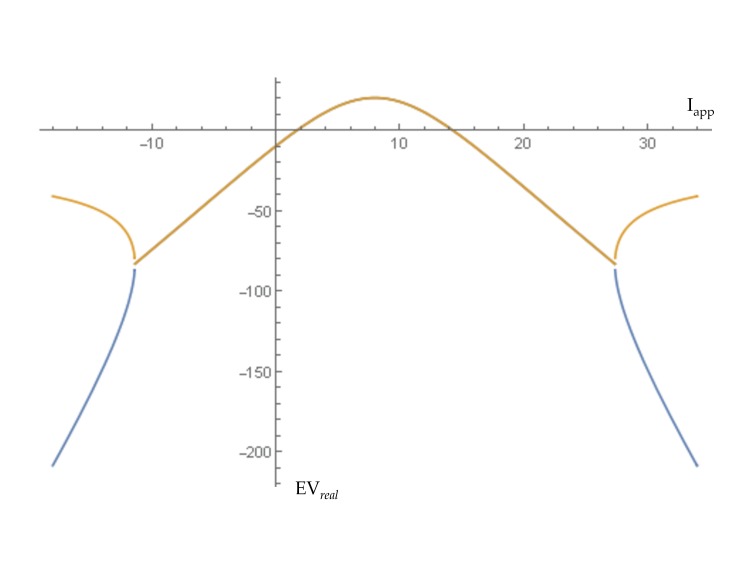
Transition to self-sustained oscillations in a single brain region.For the generic 2D oscillator model this shows the real parts of eigenvalues at equilibrium as the level of input (Iapp) to a region is increased. A transition to self-sustained oscillations in a local region occurs where this curve crosses zero. That regime is bounded by supercritical Hopf bifurcations at Iapp = 2.0 and Iapp = 14.